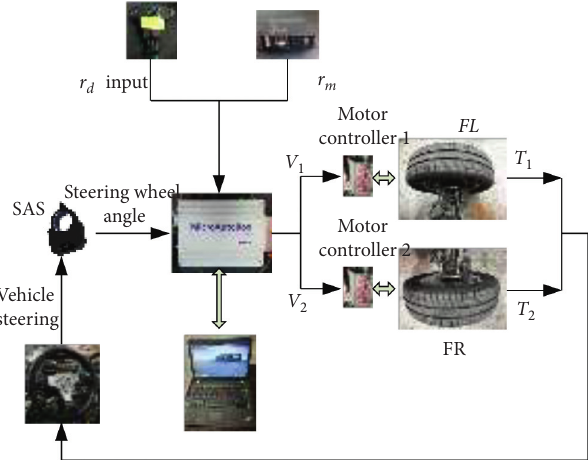
Figure 4: The flow chart of the proposed control schema.